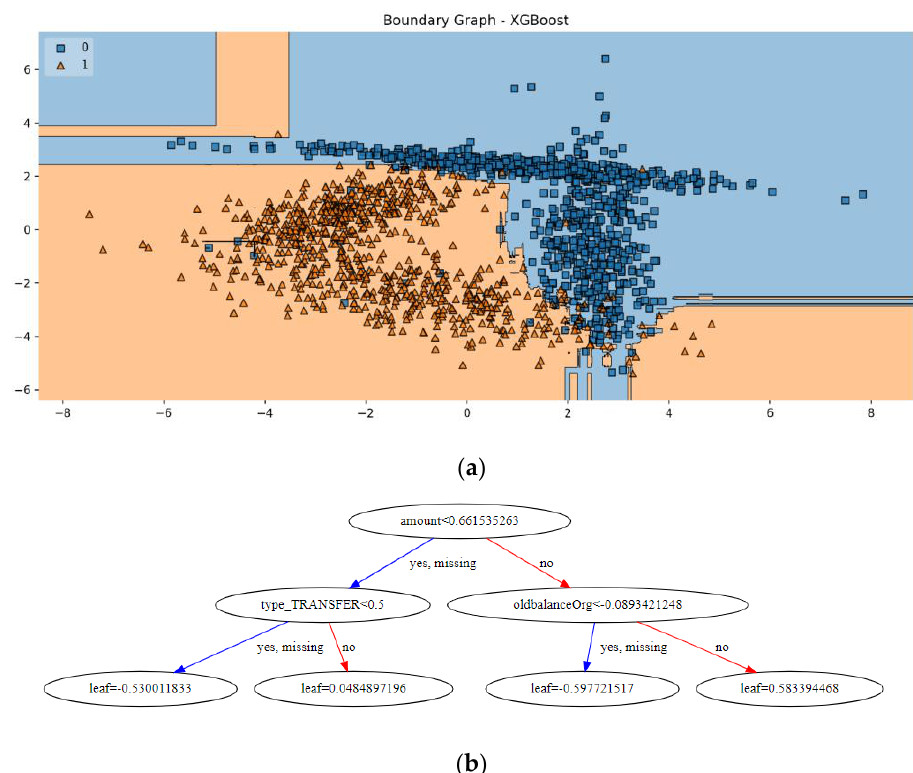
Figure 7. Visualization of XGBoost ( a ) Decision Boundaries ( b ) Tree Visualization.